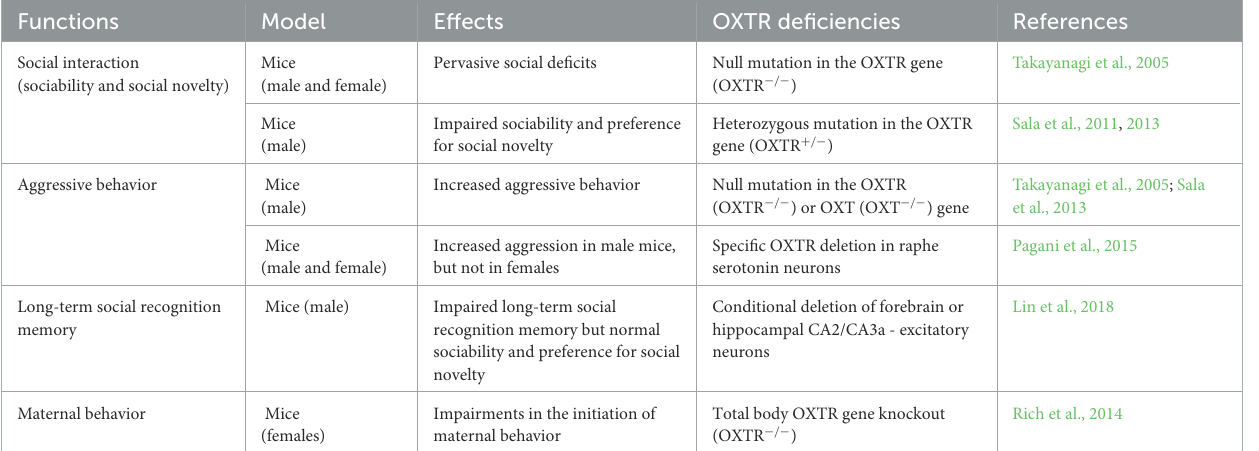
TABLE 1 Summary of behavioral implications of OXT/OXTR